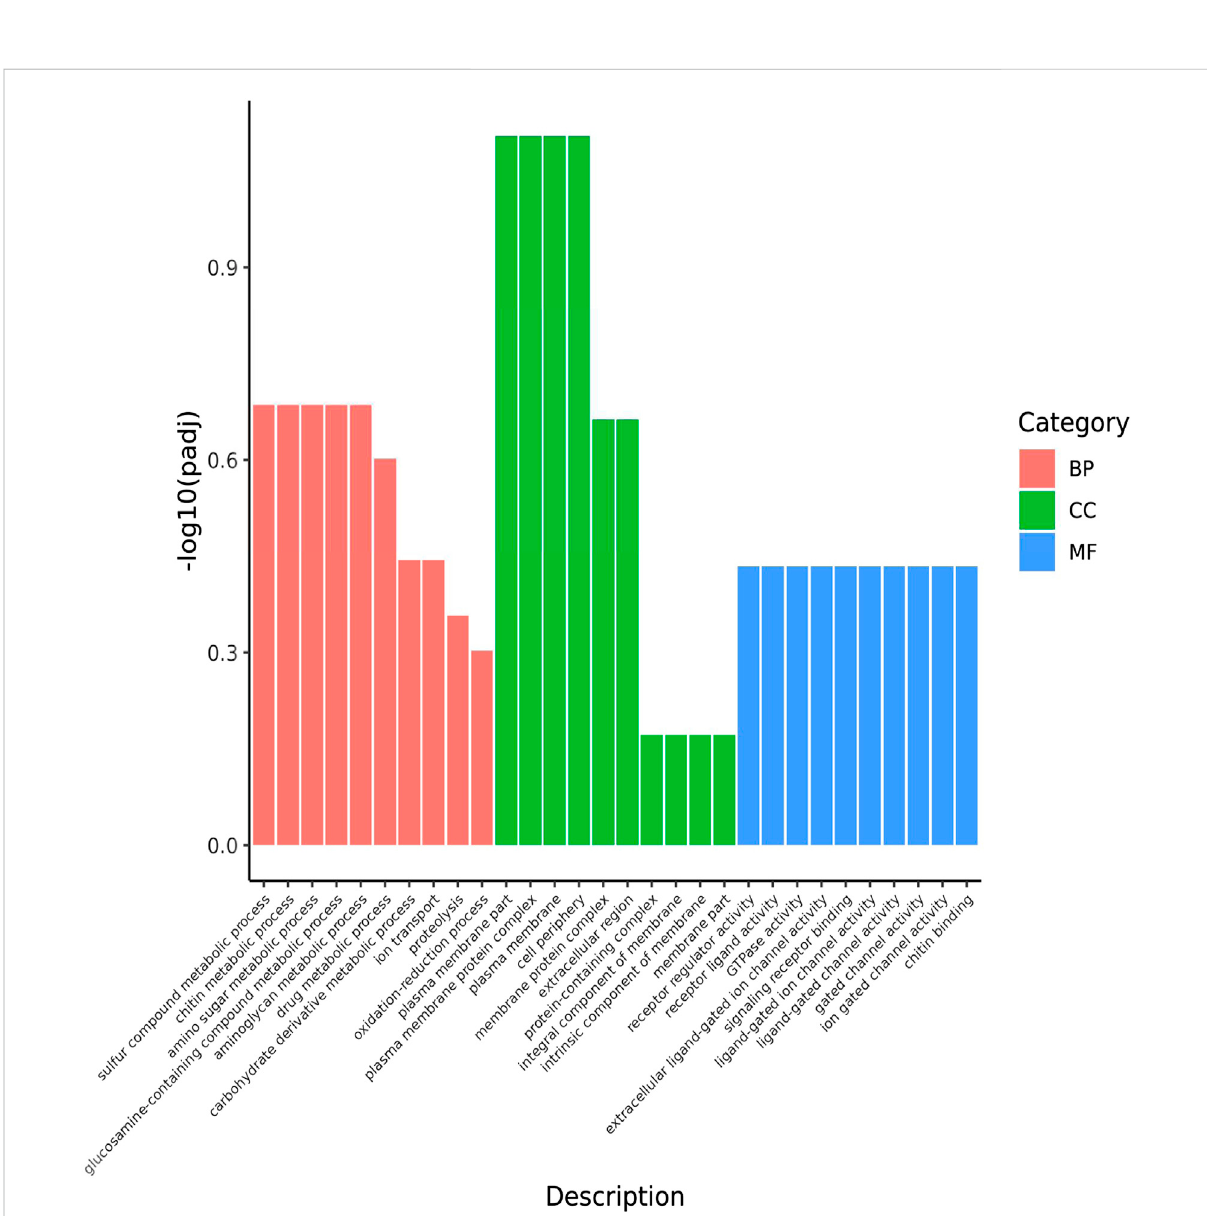
GOclassi fi cationofDEGssharedbythe3comparativecombinations.Theabscissainthe fi gureisGOterms;theordinateisthesigni fi cancelevel of GO Term enrichment, which is represented by -log10 (padj), and different colors represent different functional categories. BP: DEGs enriched for biological process; CC: DEGs enriched for cellular components; MF: DEGs enriched for molecular function. The same is